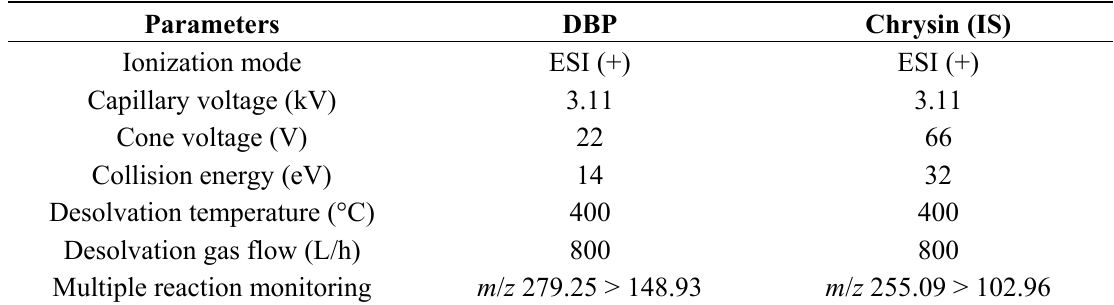
Table 5. Mass spectrometric conditions of DBP and chrysin (internal standard,